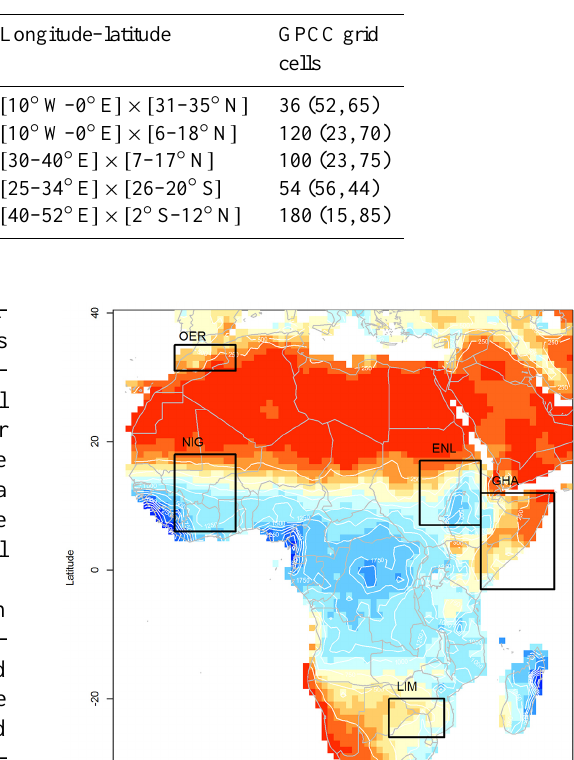
Table 1. Geographical extent of the African regions and number of grid cells analysed for each data set. For GPCC, the percentage of stations per grid and the percentage of pixels without stations are respectively shown in parentheses.